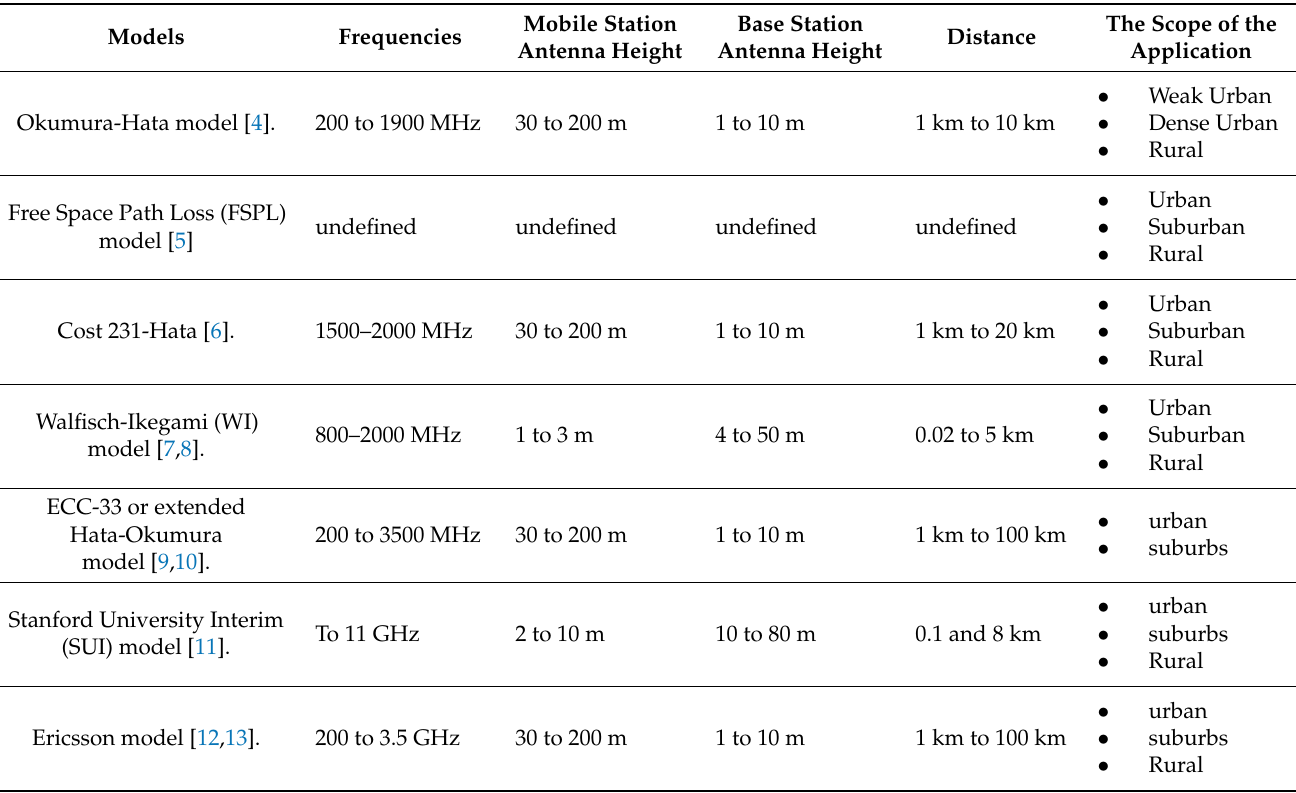
Table 1. The empirical and semi-empirical model parameters.